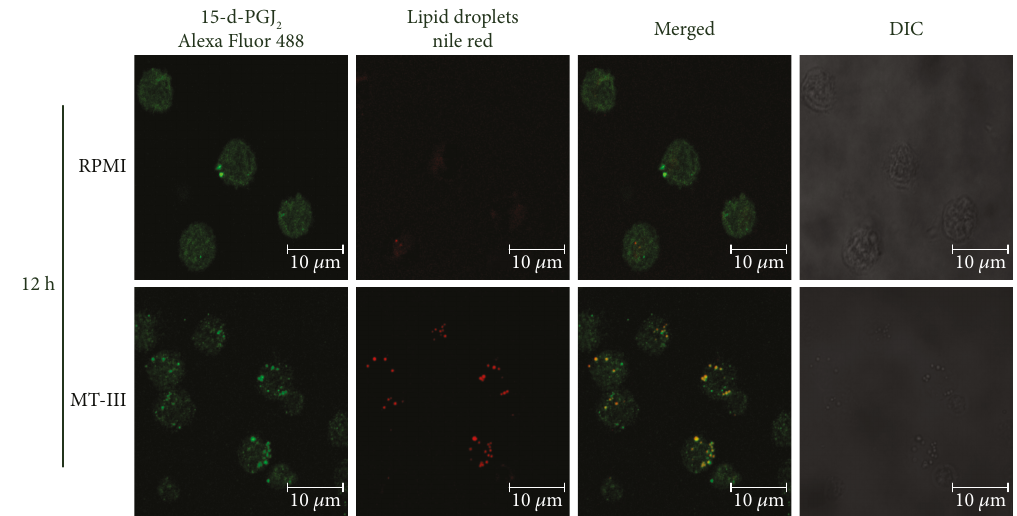
Figure 4: MT-III-induced LDs compartmentalize 15-d-PGJ MT-III (0.4 μ M) for 12h were labeled for LDs (Nile Red) and for 15-d-PGJ image shows colocalization of 15-d-PGJ